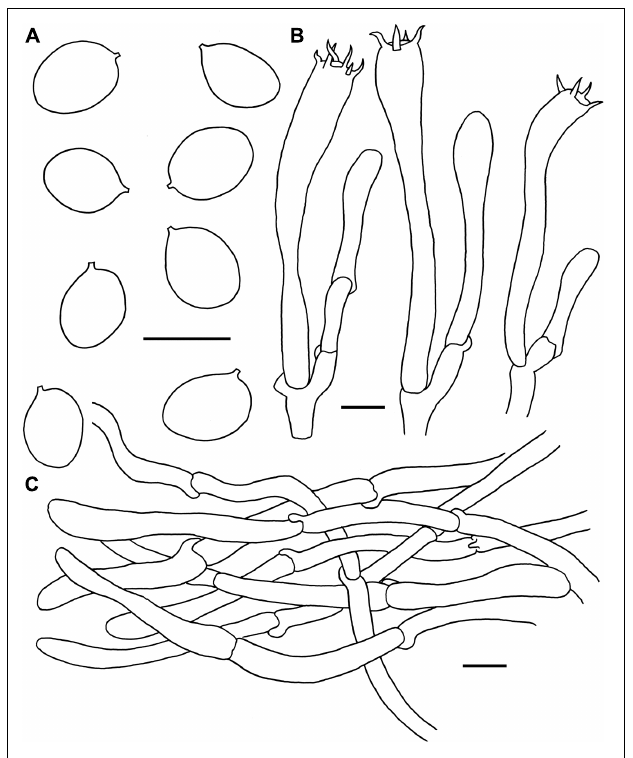
FIGURE 7 | Microscopic features of Craterellus lutescens (FHMU6544). (A) Basidiospores. (B) Basidia. (C) Pileipellis. Scale bars = 10 µ m. Drawings by Y.-Z. Zhang.